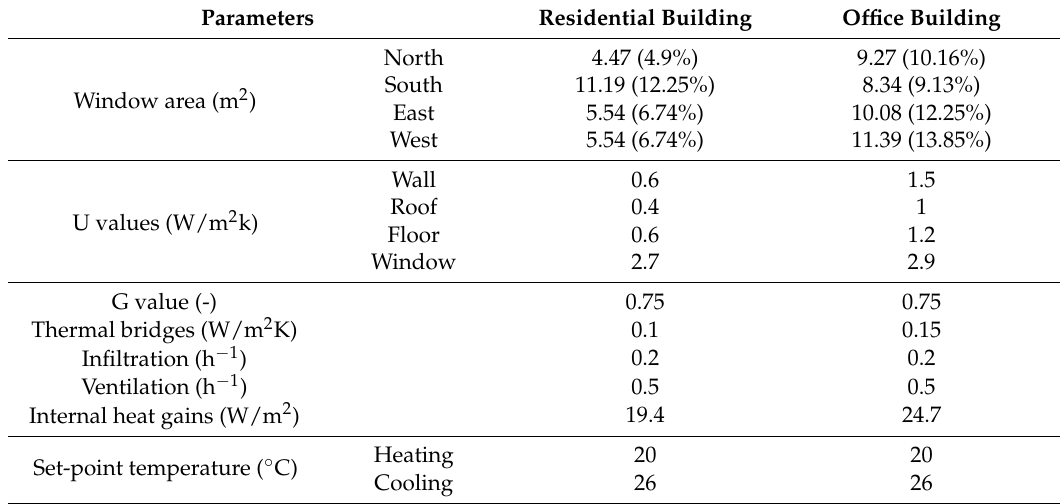
Table 2. Input data of the residential and office building in the TRNSYS simulation